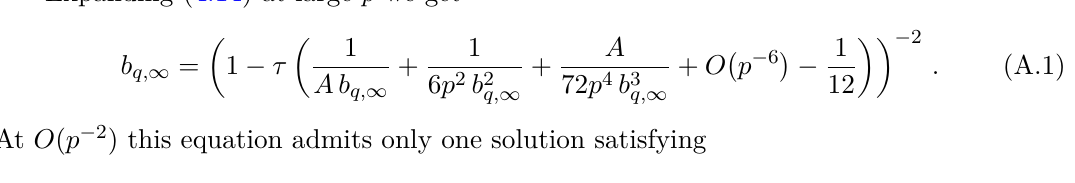
JHEP11(2020)086